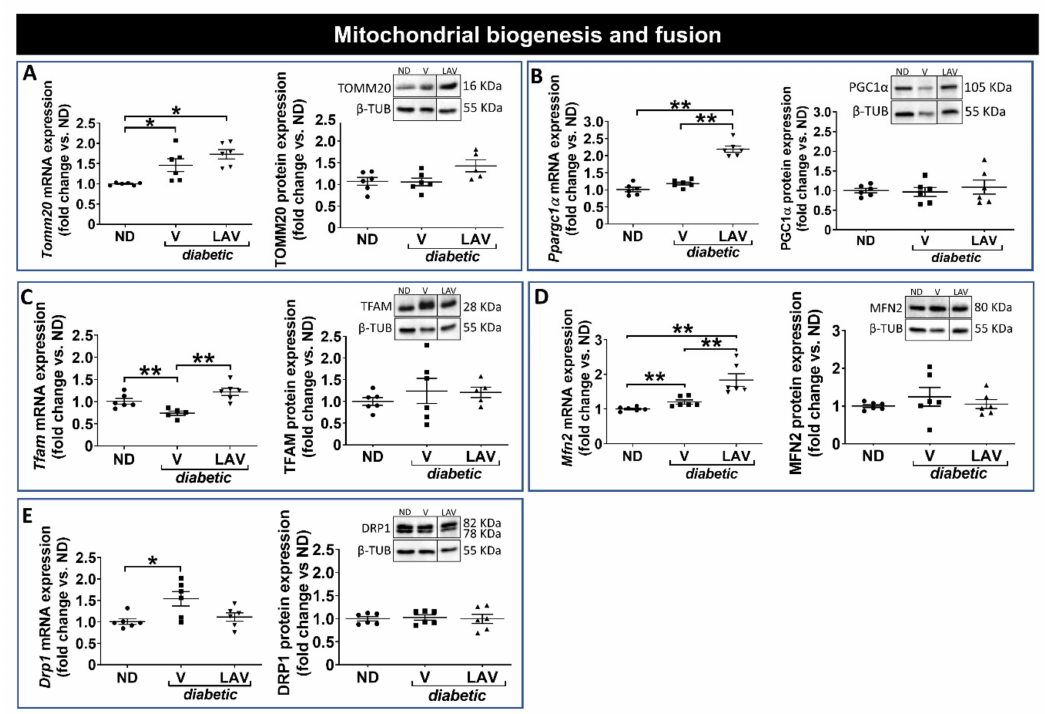
Figure 4. Focused transcriptomic analysis of mitochondrial biogenesis and dynamics. Graphs show the mRNA and protein expression levels of components involved in mitochondrial protein import (TOMM20) ( A ); biogenesis (PCG1 α and TFAM) ( B , C ); and fussion / fission (MFN2 and DRP1) ( D , E ). Data (fold changes vs. ND) are expressed as individual values and means ± SEM of n = 6 per group. * p < 0.05 and ** p < 0.01. Representative western blots show n = 1 sample per group, presented in the same order as in the graphs. Line within blots indicates non-adjacent lanes on the same membrane (see online Supplementary gels file S1).